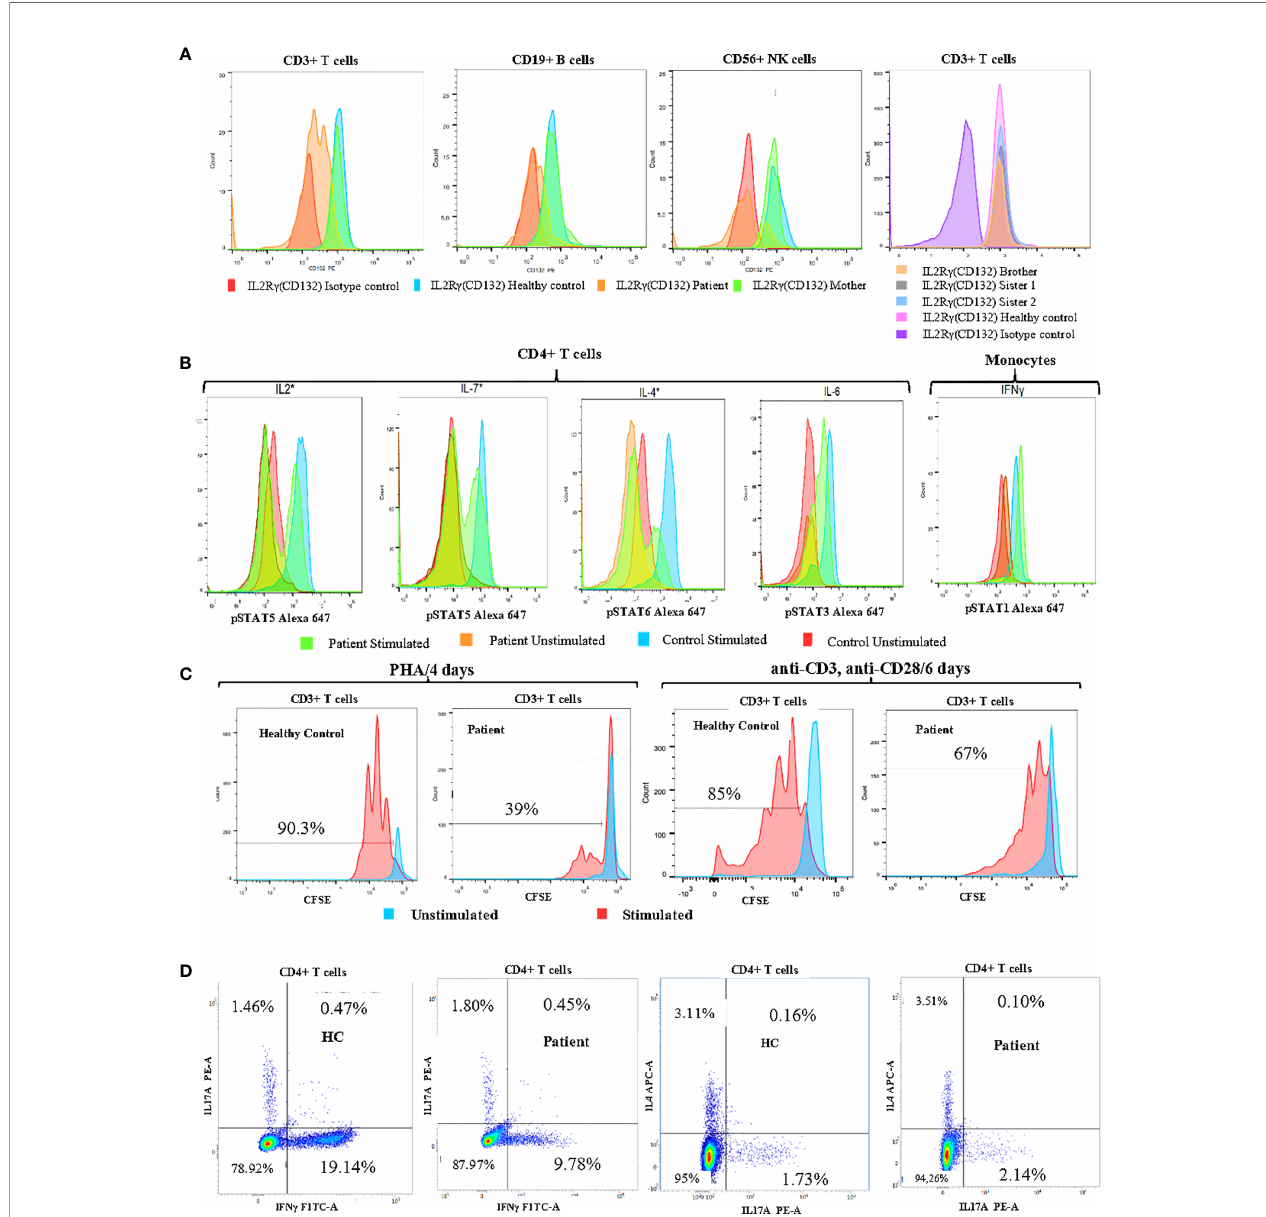
FIGURE 2 | Immune functional and proliferation assays in subsets of lymphocytes. (A) Flow cytometry analysis of CD132 ( g c) expression on T, B and NK cells of the patient, his mother, and healthy control, and screening of siblings for CD132 expression on T cells. (B) Histogram of CD4+ T cell and monocyte response with STAT phosphorylation to several g c dependent (IL-2, IL-4, IL-7) and independent (IL-6, IFN- g ) cytokines in whole blood of patient. (C) Analysis of proliferation of healthy control (HC) and patient CFSE labeled cells with the indicated stimuli: 4 days of culture with Phytohemaglutinin (PHA) and 6 days with anti-CD3/anti-CD28 monoclonal antibodies. (D) The percentages of IL-17A, IFN g and IL-4-producing CD4+ T cells from patient and age-matched control using PMA/Ionomycin stimulation in the presence of monensin for 5 hours. *Gamma chain dependent cytokines; the others are gamma chain